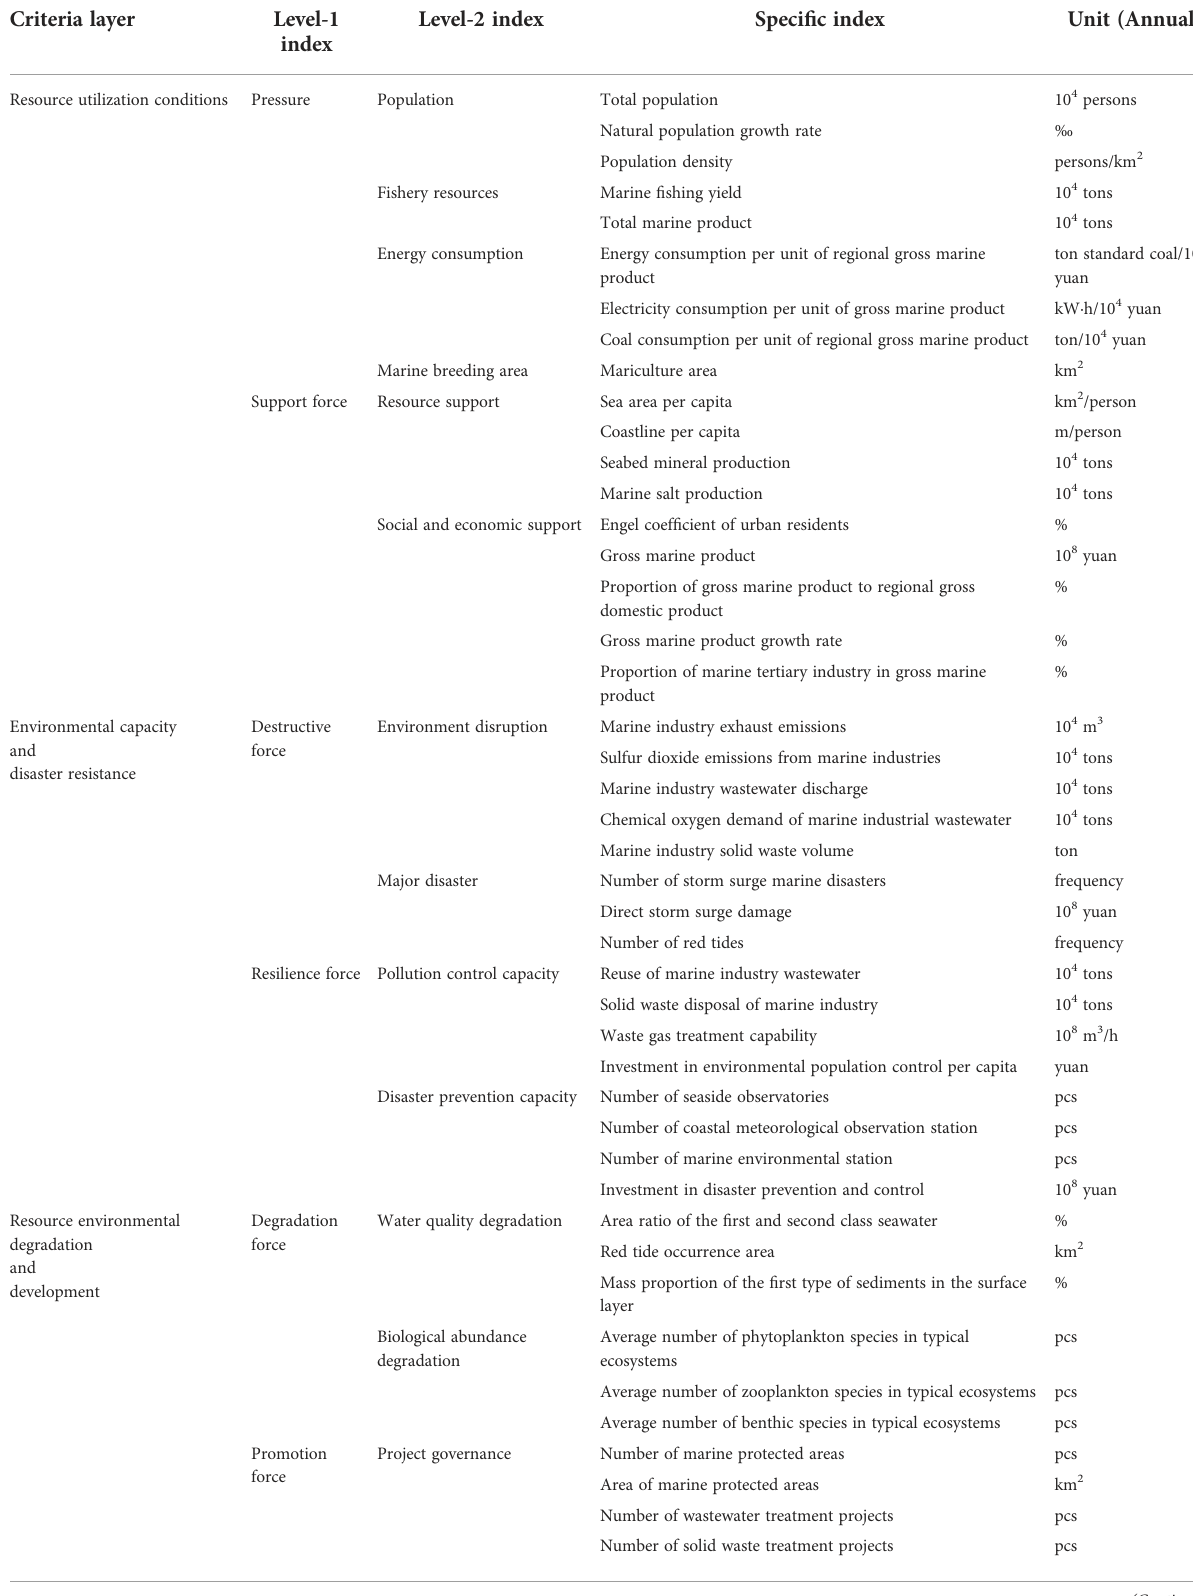
TABLE 1 Evaluation index system of the marine resources and environmental carrying